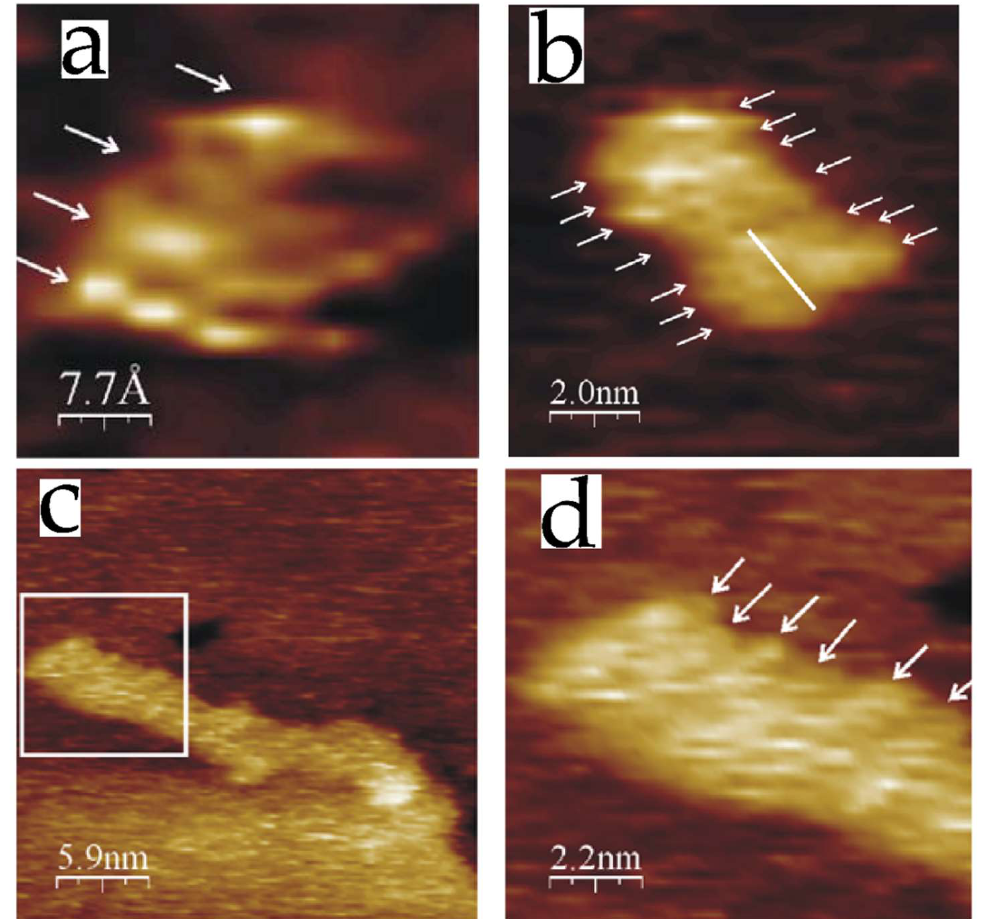
Figure 5. STM images of monomers, dimers, and oligomers of A β 1–40 on atomically flat gold surfaces. Monomers contain three or four parallel strands (arrows) ( a ). Dimers are constituted by two monomers ( b ). Oligomers resulted from the fusion of monomers or dimers ( c ), the arrows are indicating the parallel strands ( d ). Reprinted with permission from Ref. [89]. Copyright (2006), Elsevier.